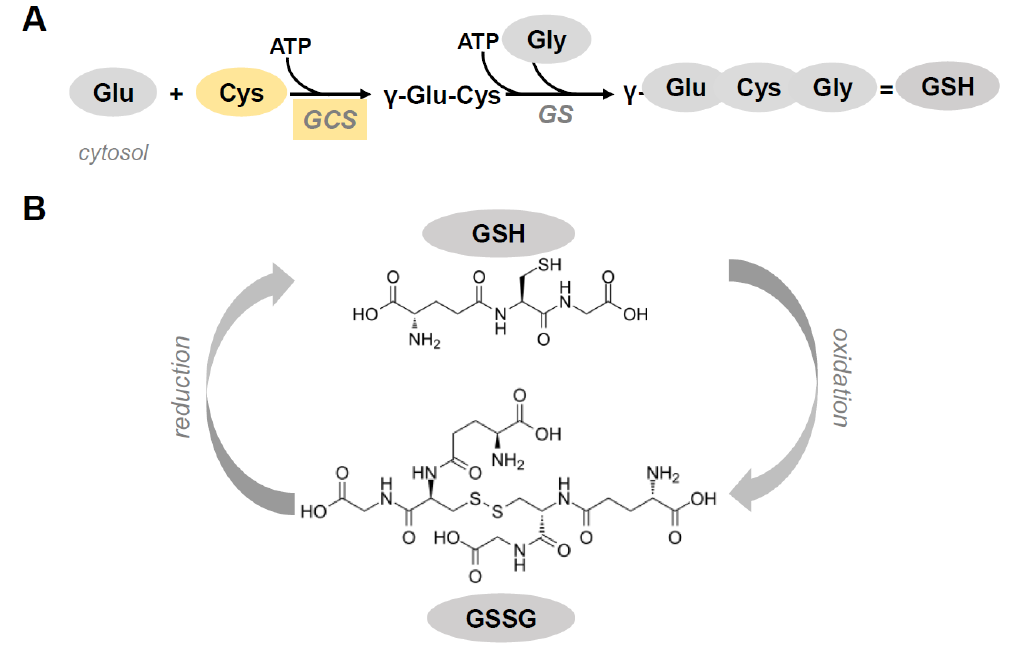
Figure 1. ( A ) Glutathione (GSH) synthesis in cytosol. GSH is synthesized by the concerted action